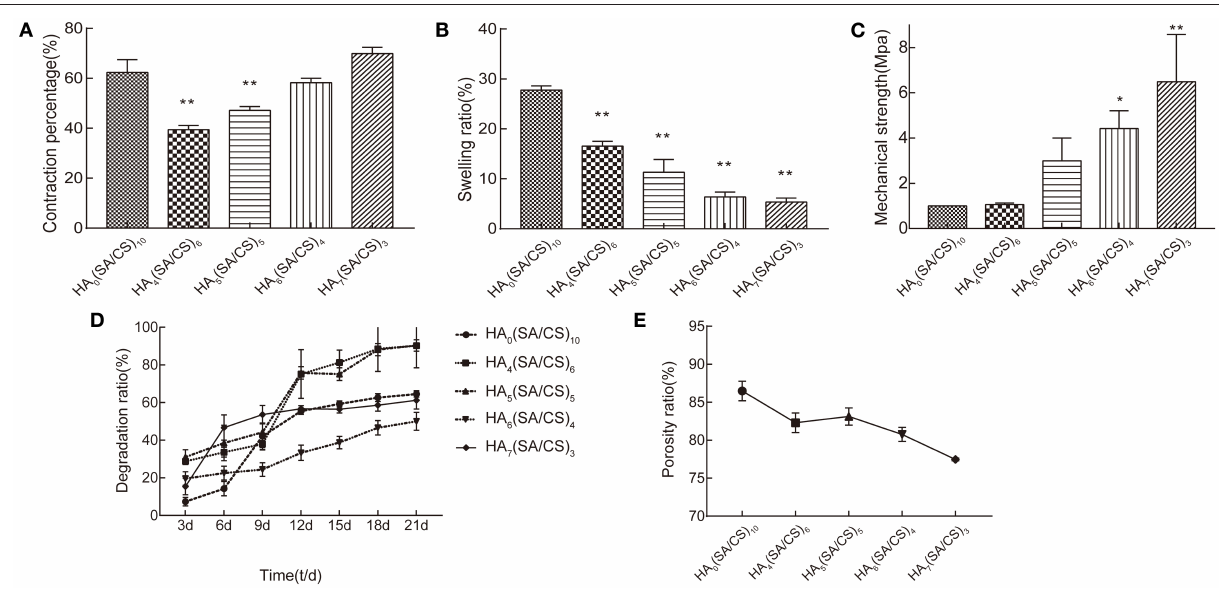
being 50.01% on day 21. In HA 7 (SA/CS) 3 scaffold group, the degradation amount accounted for 31.29% of the total stent from the 3rd to the 6th day, and then the degradation